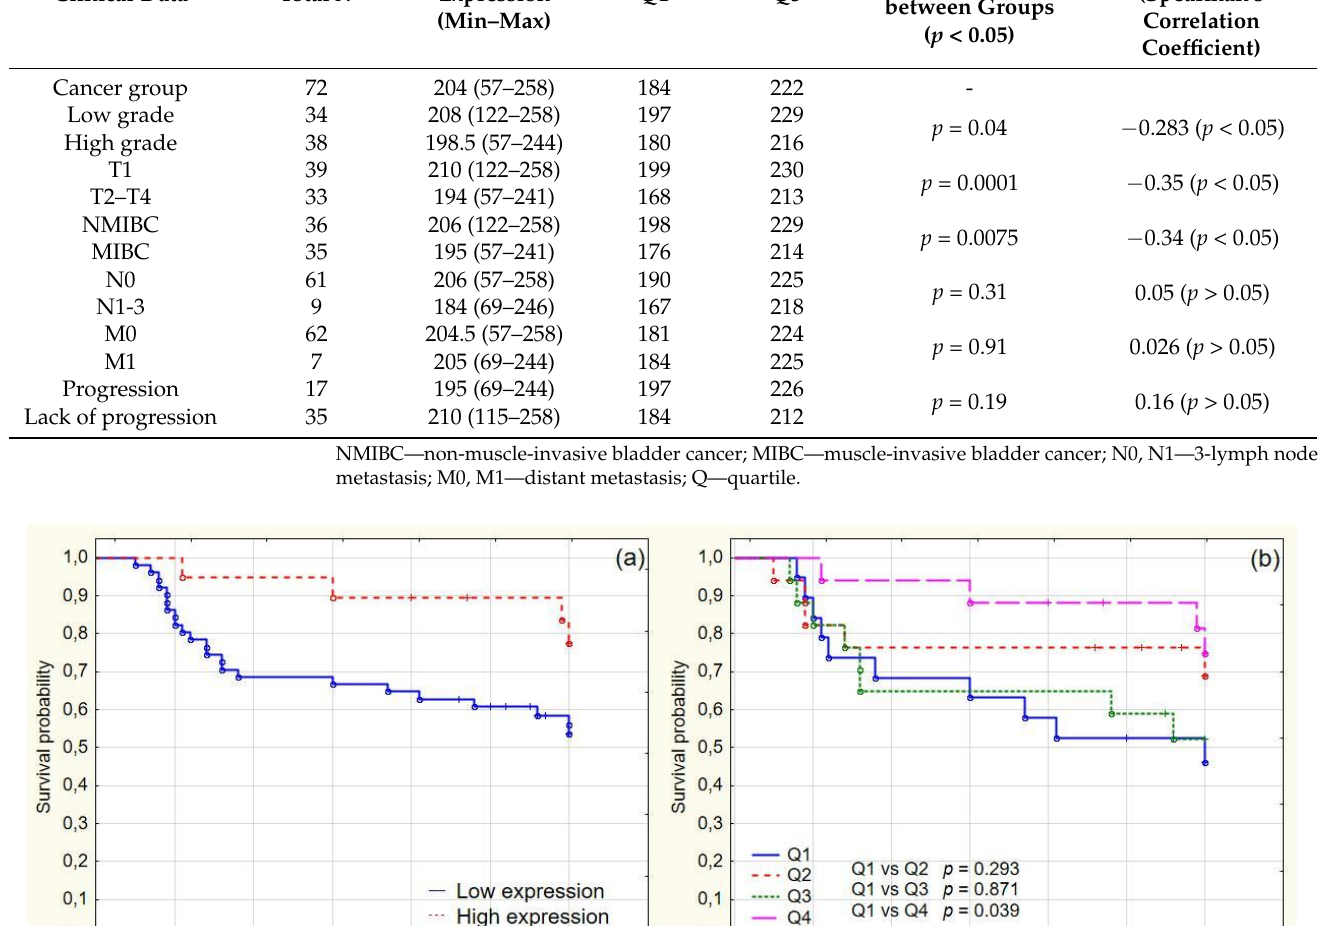
6 of 13 Table 2. Correlation between CDK9 expression and clinical predictors for bladder cancer.